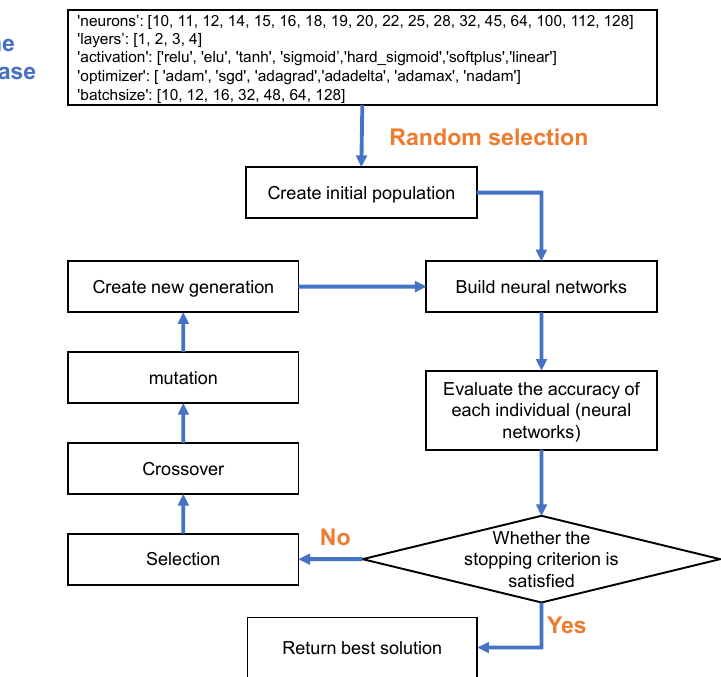
Figure 2. Flow chart of genetic algorithm.